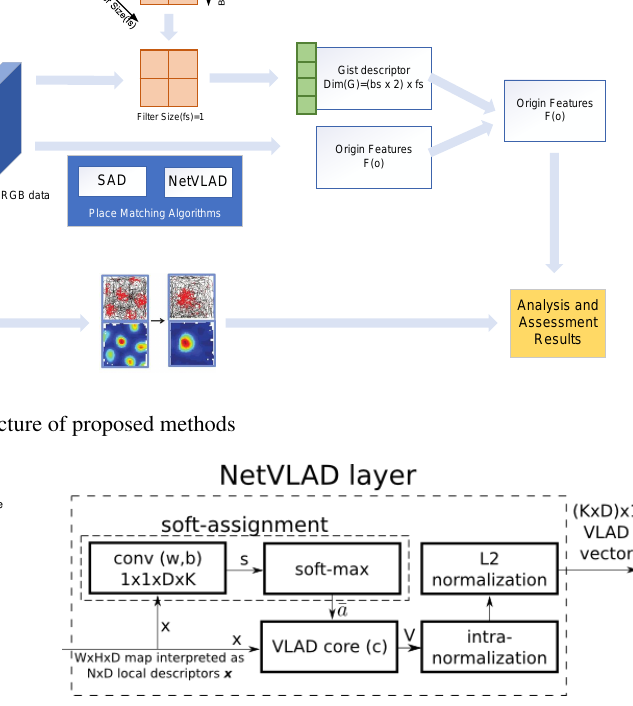
Figure 3. The result of gist descriptor with different scale images Figure 4. Architecture of NetVLAD